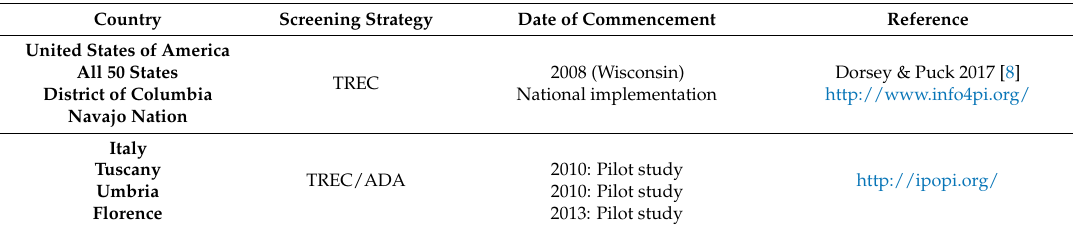
Table 1. Worldwide status of newborn screening programs for primary immunodeficiency diseases (PID). TREC: T-cell receptor excision circles; KREC: kappa-recombining exclusion circles; ADA: adenosine